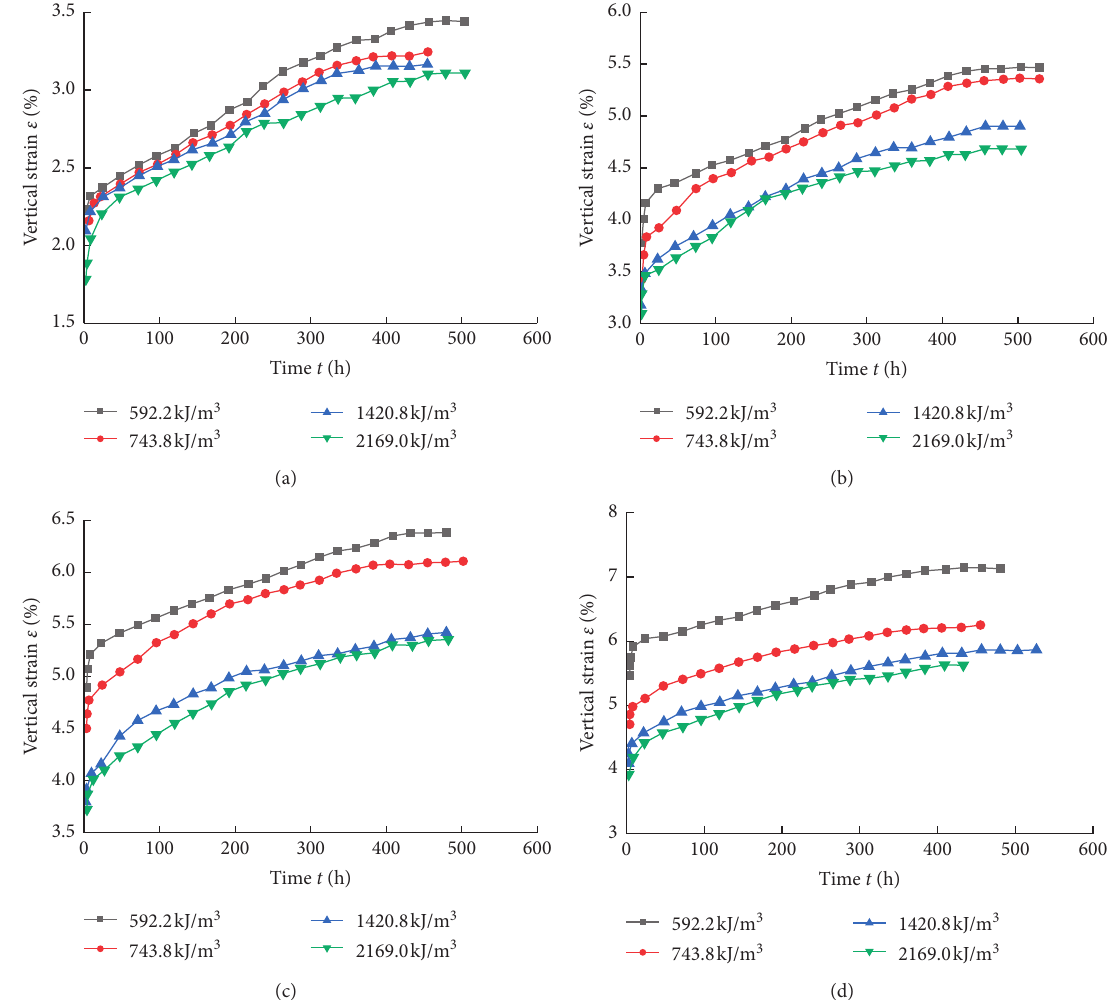
Figure 3: Strain-time curve with different vertical stress and compaction energies. (a) Vertical stress σ � 500 kPa. (b) Vertical stress σ � 1000kPa. (c) Vertical stress σ � 1500kPa. (d) Vertical stress σ �